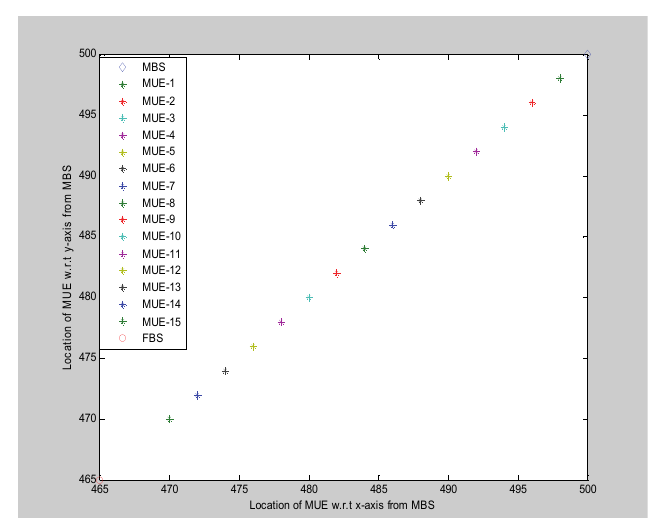
Fig. 6. Location of MUEs w.r.t. MBSs.